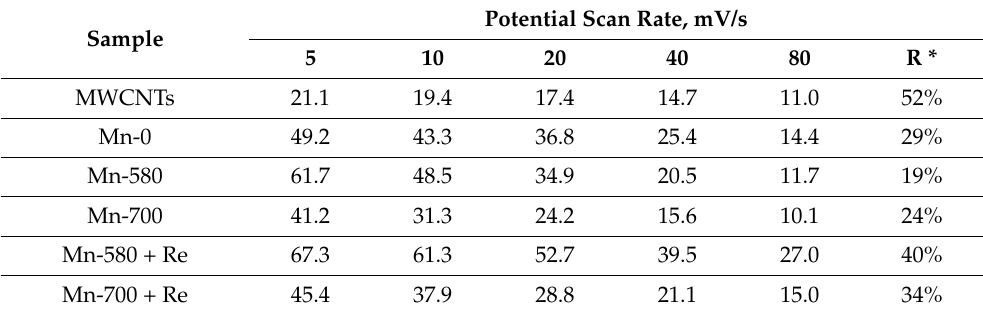
Table 4. Specific capacitance ( Cs ) versus potential scan rate for MWCNTs and composites.